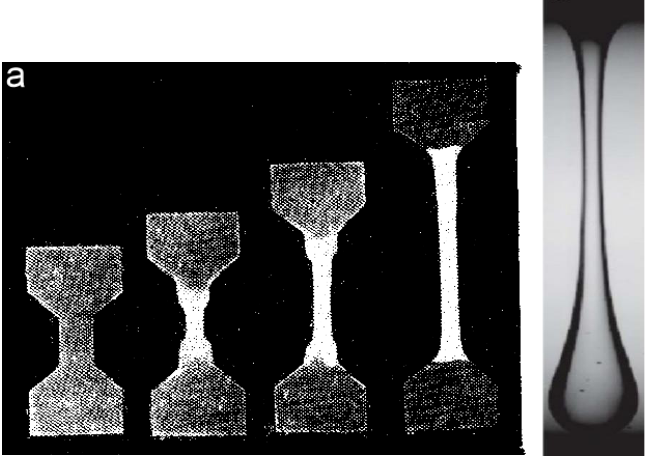
Figure 31. Heterogeneous stretching: necking ( a ) and gradual contraction ( b ).